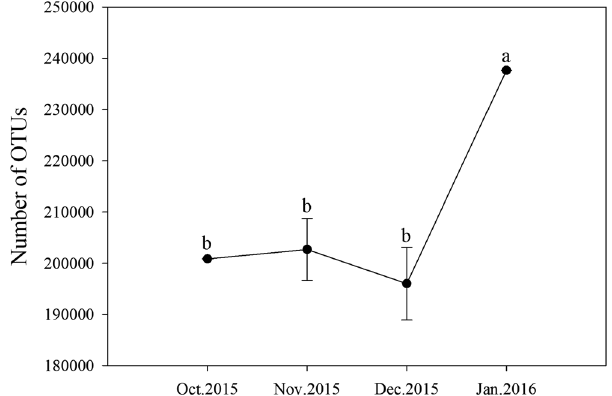
Figure 3. Number of OTUs in Dendroctonus armandi larval gut bacteria in each month from October 2015 to January 2016. Note: Values are presented as means ± SE. Values with the different lowercase letters in the